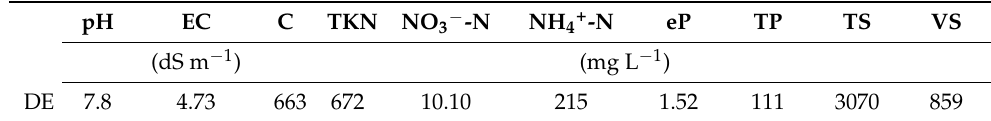
Table 3. Physicochemical characteristics of the treated dairy effluent